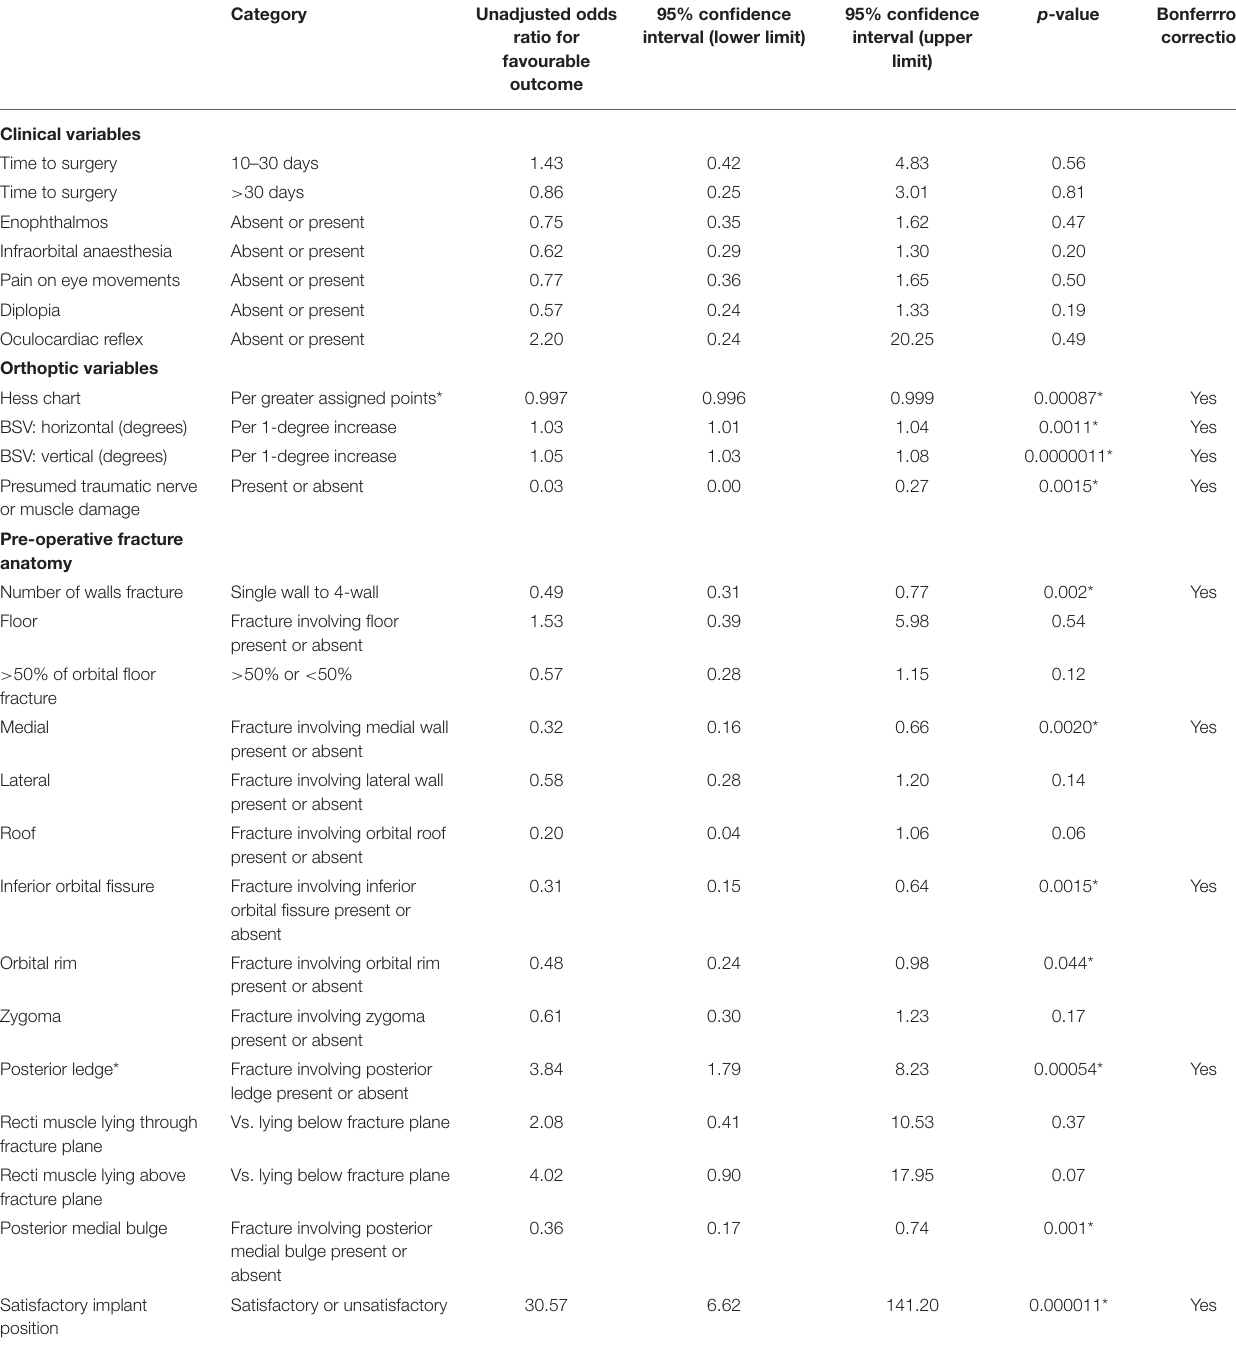
Table detailing clinical, orthoptic, and fracture variables included into univariate logistic regression model as predictors of defined surgical success. Statistical significance determined at p < 0.05, marked * . Bonferroni correction was used reduce statistical errors of multiple comparisons. The Aylward system is used in the numeric grading of Hess chart deviations. Horizontal BSV is the maximal horizontal dimension in degrees, and vertical BSV is the maximal vertical dimension in degrees. Fracture anatomy parameters are demonstrated in Figures 1 , 2 . Fracture anatomy descriptions are based on pre-operative CT imaging.